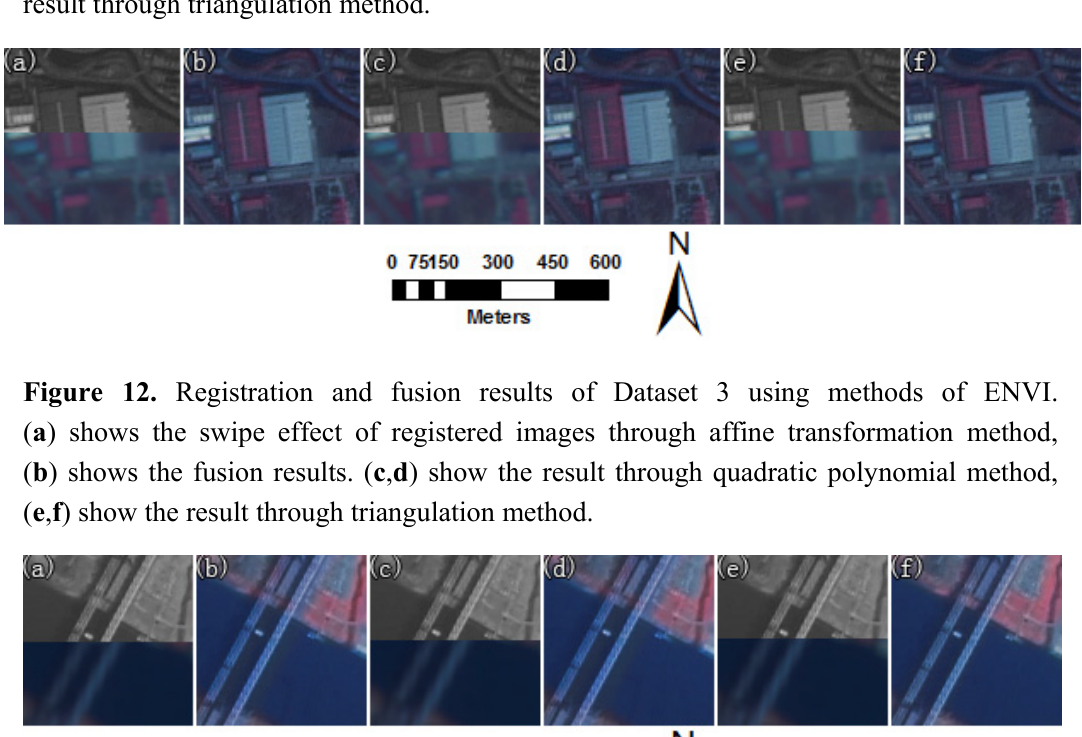
Figure 11. Registration and fusion results of Dataset 2 using ENVI methods. ( a ) shows the swipe effect of registered images through affine transformation method, ( b ) shows the fusion results. ( c , d ) show the result through quadratic polynomial method, ( e , f ) show the result through triangulation method.